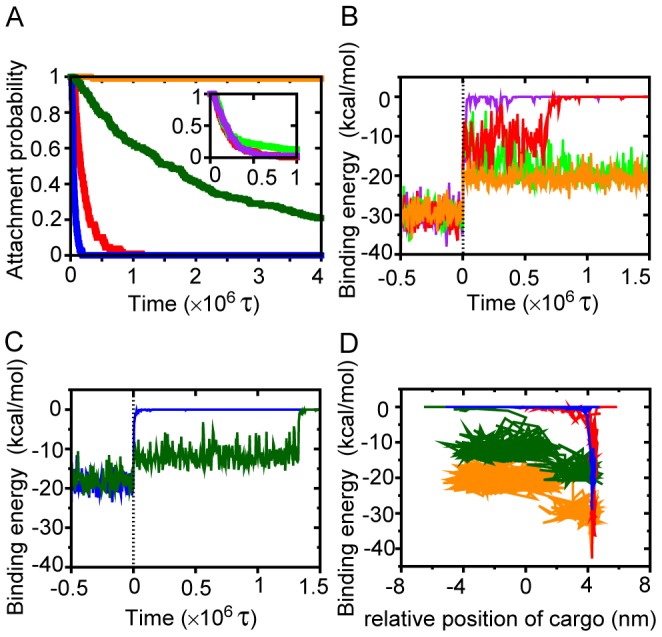
Representative time courses of dissociation of the head from MT after T → D switch.(A) The probability of the KIF1A head still attached on MT as a function of duration time from the T → D switch. The red, blue, orange, and green lines correspond to the cases of [cargo/strong], [cargo/weak], [stand-alone/strong], and [stand-alone/weak], respectively. The inset is the corresponding results of [cargo/strong] with the three sizes of cargoes, a smaller cargo with friction 2.5×10−8 (light-green), a middle one with 1.1×10−8 (red), and a larger one with 0.53×10−8 (magenta). (B)(C) The binding energy between the KIF1A head and MT as a function of duration time from the T → D switch for case of the strong interaction (B), and for the case of the weak interaction (C). (D) A dissociation trajectory in the plane (EB, zrelative) after the T → D switch, where EB is the binding energy between KIF1A and MT, and zrelative is the position of the cargo-analog (the C-terminal) relative to that of the head (i.e., zcargo-zhead). The color assignments in (B) (C) (D) are the same as those in (A).